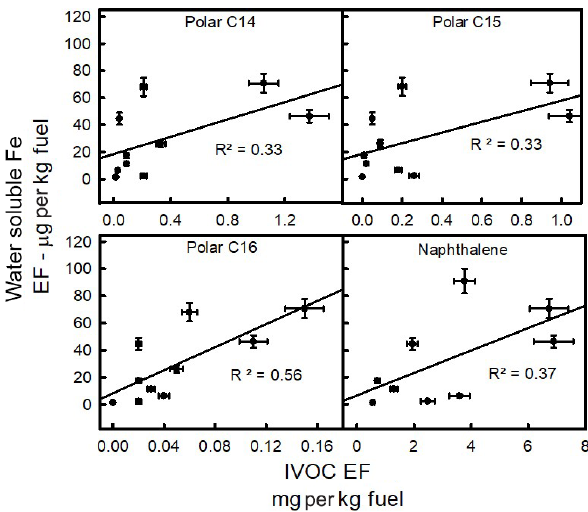
Figure 5. Scatter plots of water-soluble iron versus the sum of IVOCs reported in EF (grams per kilogram of fuel).